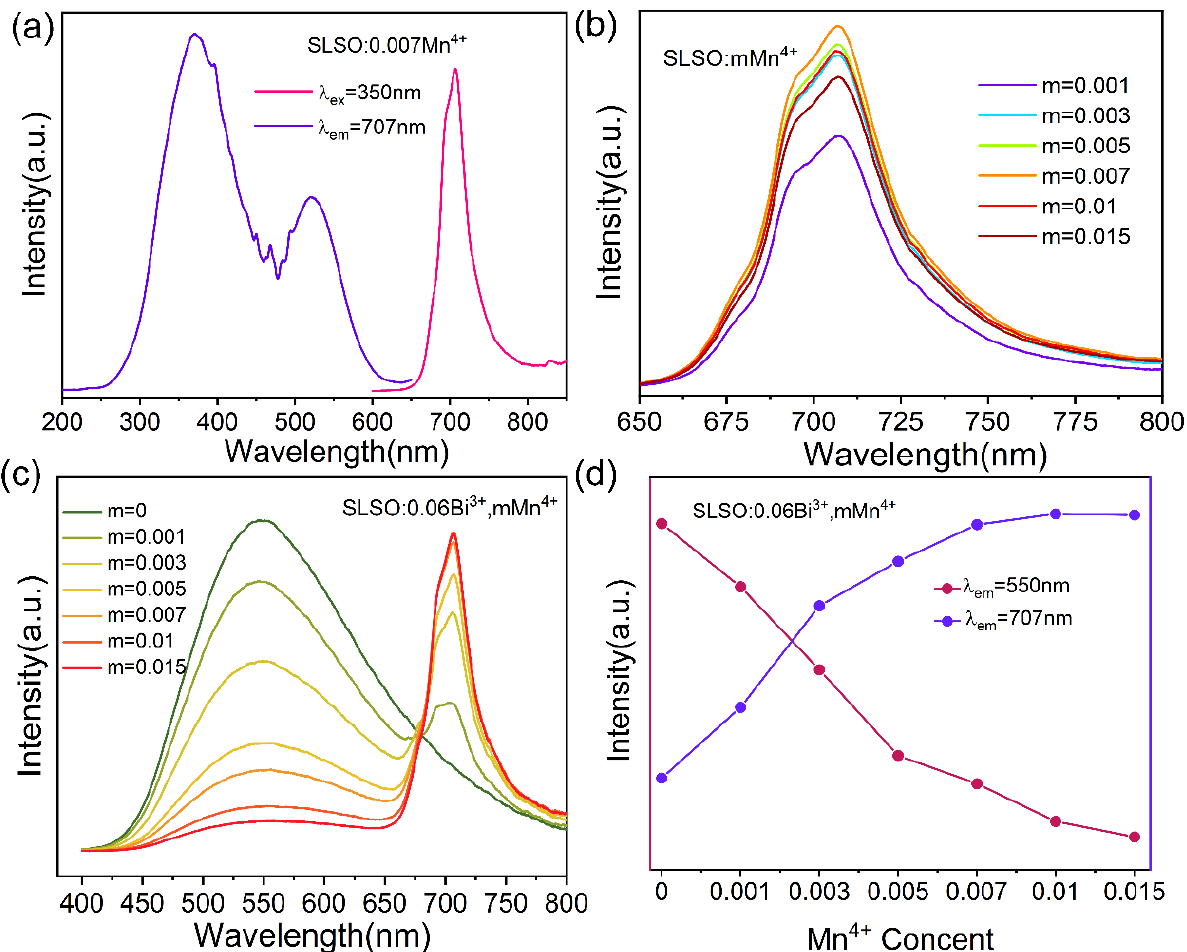
Figure 5. ( a ) Excitation and emission spectra of SLSO:0.007Mn 4+ ; ( b ) emission spectra of SLSO: m Mn 4+ ; ( c ) emission spectra of SLSO:0.06Bi 3+ , m Mn 4+ ( λ ex = 350 nm); ( d ) the emission intensities of SLSO:0.06Bi 3+ , m Mn 4+ ( λ em = 550 and 707 nm).